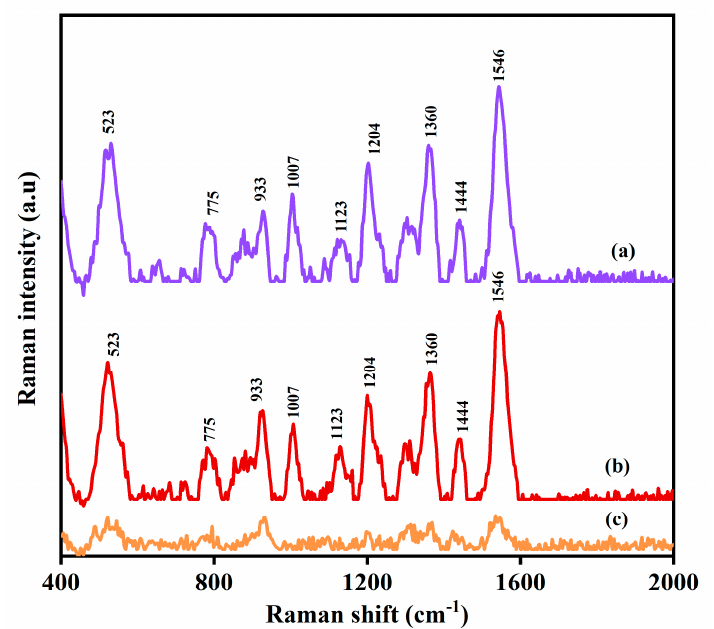
Figure 5. SERS spectra of: ( a ) MPN in human blood plasma; ( b ) SERS spectrum after separation by HPLC and detection by SERS in an HPLC-SERS arrangement; ( c ) blank human blood plasma.